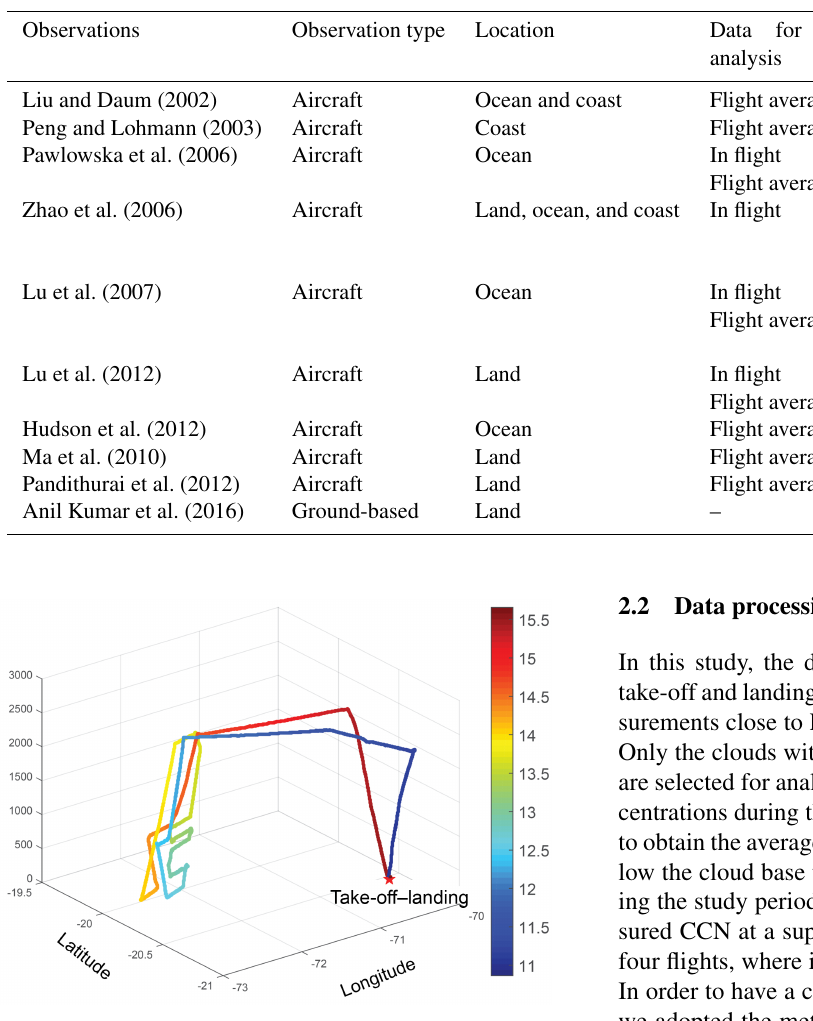
Figure 1. The flight track in 18 October; the colors represent flight time in hours